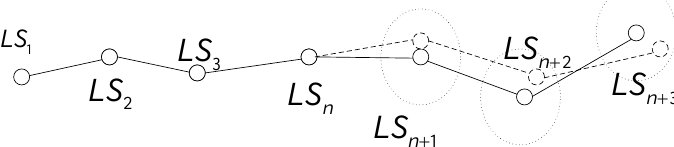
Figure 1. Schematic diagram of an inertial navigation track and a matching track